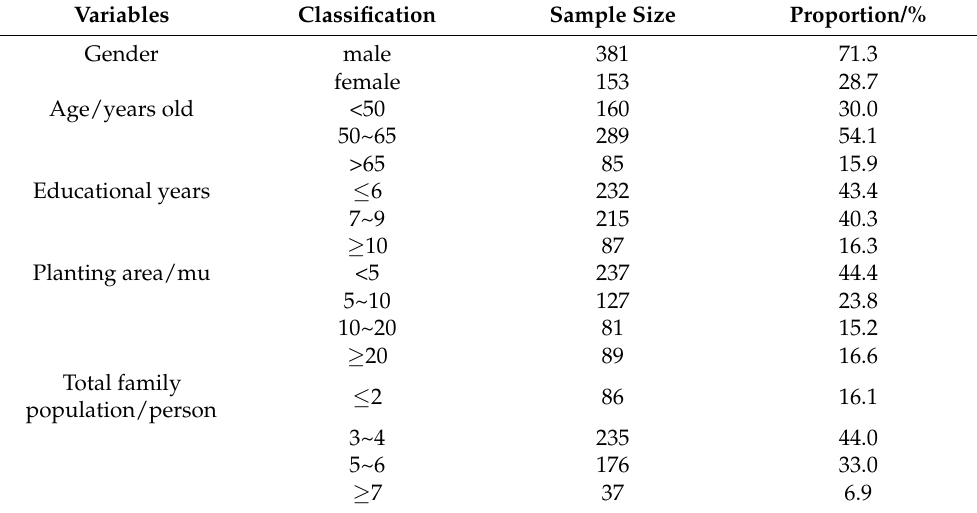
Table 1. Basic characteristics of sample